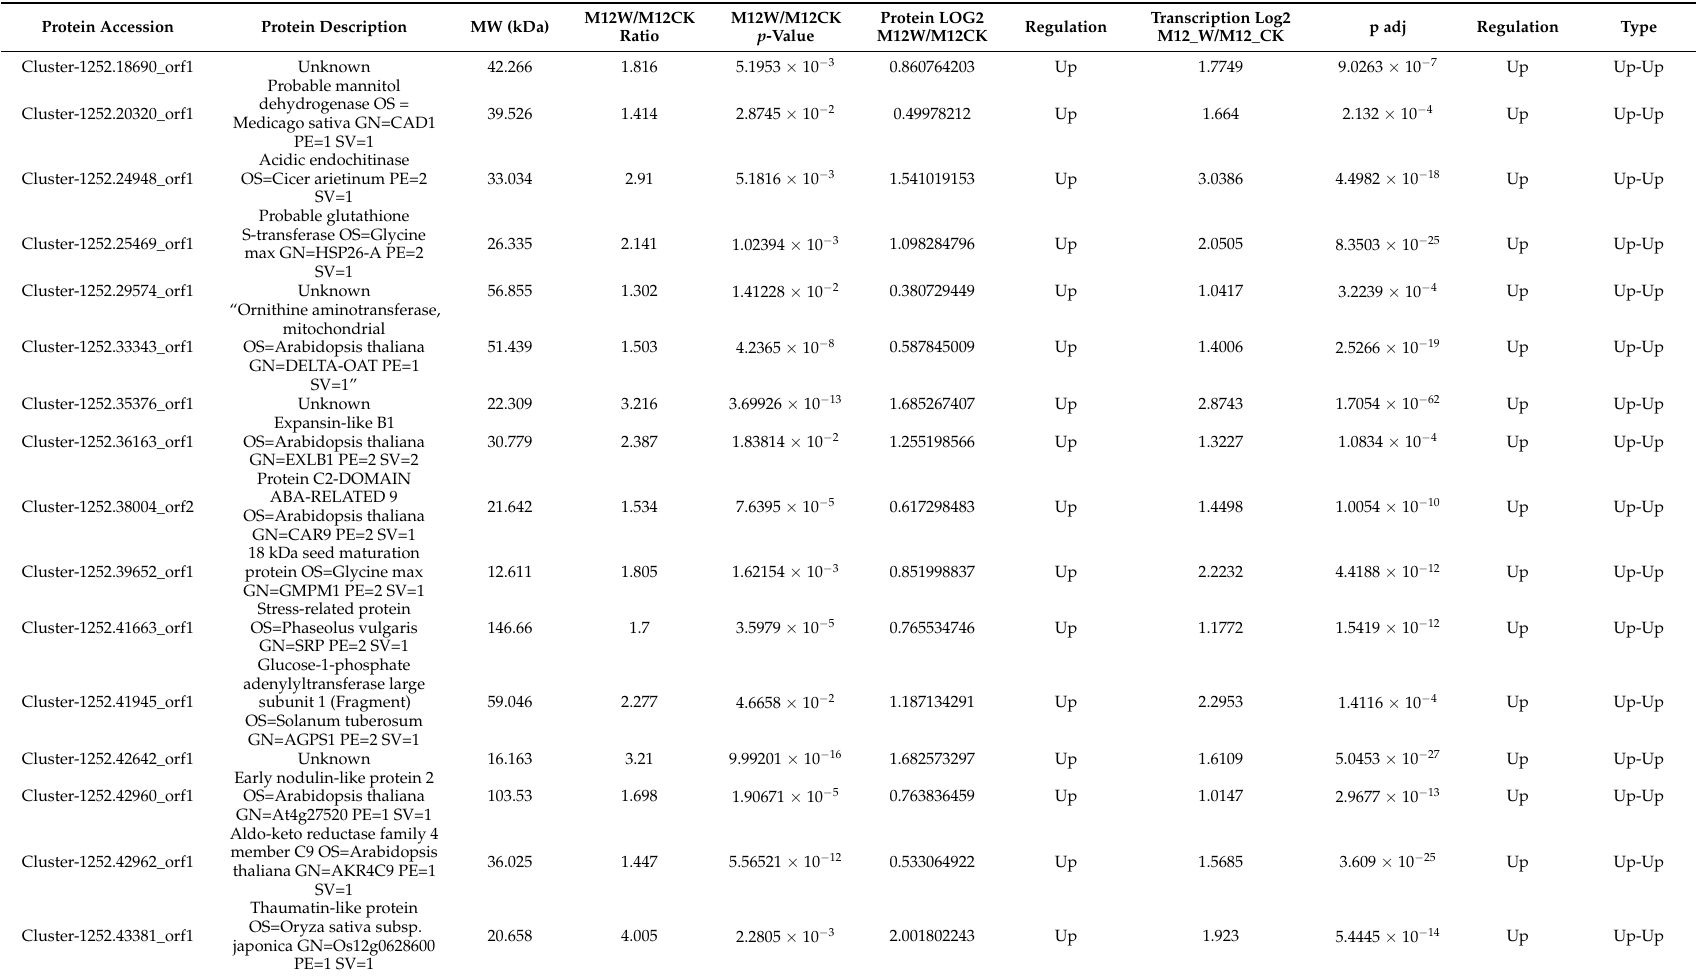
Table 4. Differentially abundant transcripts both at proteomic and transcriptomic levels in M12 under